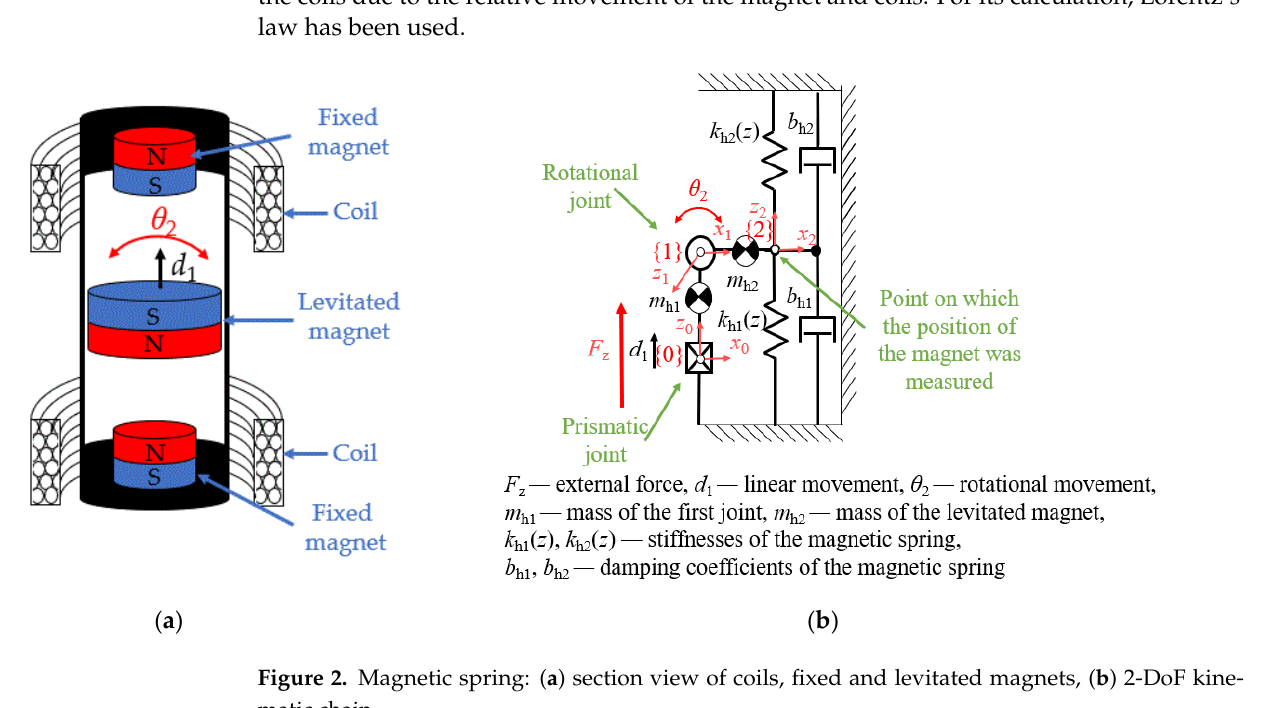
Figure 2a, the levitated magnet moves linearly along the symmetry axis z and rotates around the axis perpendicular to its symmetry axis, as described by the θ angle. The volt- age is induced in the coils due to the relative movement of the magnet and coils. For its calculation, Lorentz ’s law has been used.